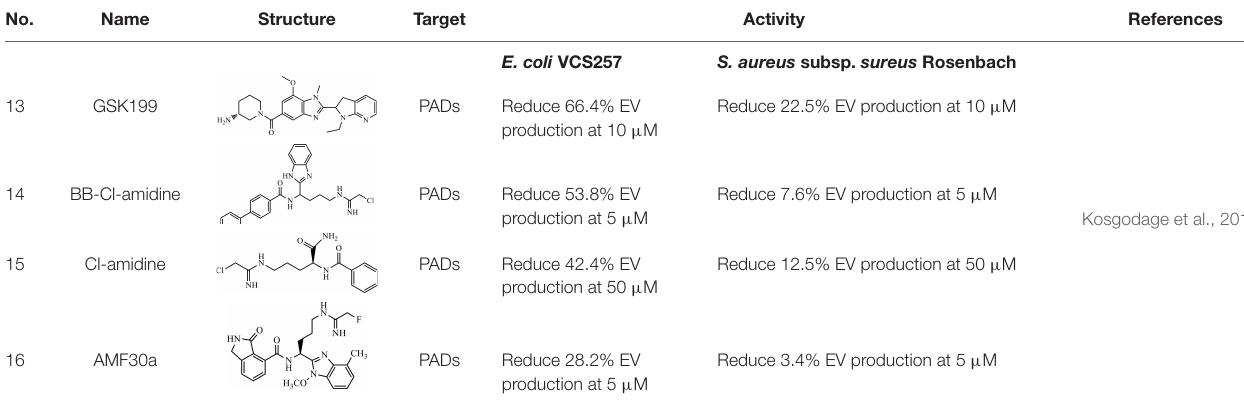
TABLE 2 | EV production inhibitors that targeting PADs. No.